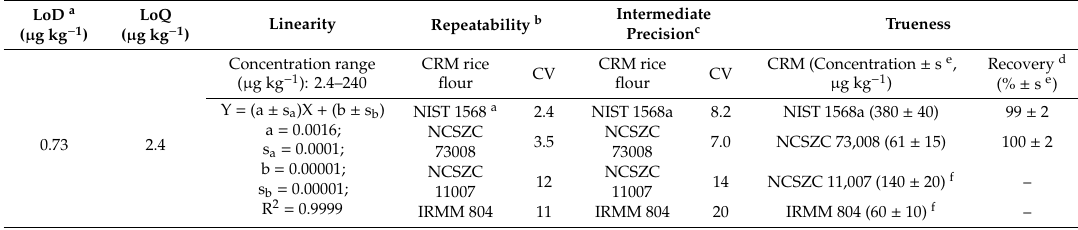
Table 1. Validation parameters for the ICP-MS determination of Se in